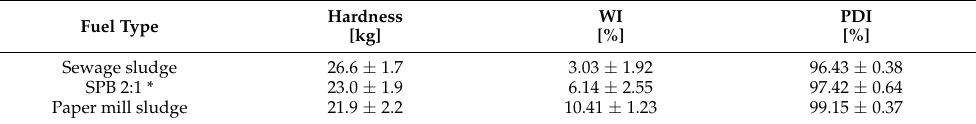
Table 4. Mechanical properties of pellets.